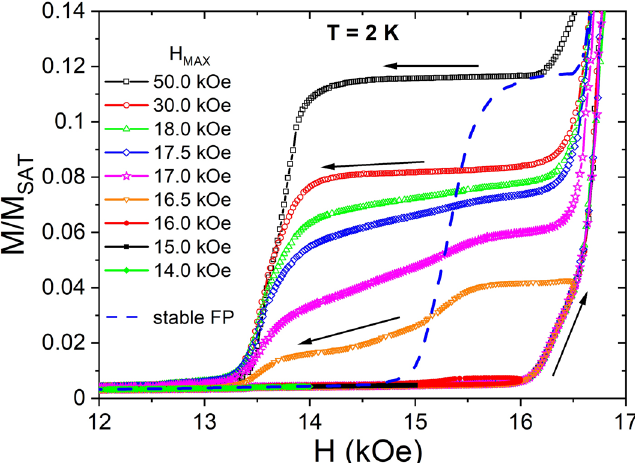
Figure 2. Field dependence of the magnetization M at 2 K after zero-field cooling. With gradually increasing field hysteresis loops can be observed. Note that distinct fractional plateaus develop only after H first reaches values close to the half plateau phase (for fields of about 16.5 kOe and above). The dashed line shows the stable fractional plateau (sFP) obtained after cooling in constant field (see Fig.